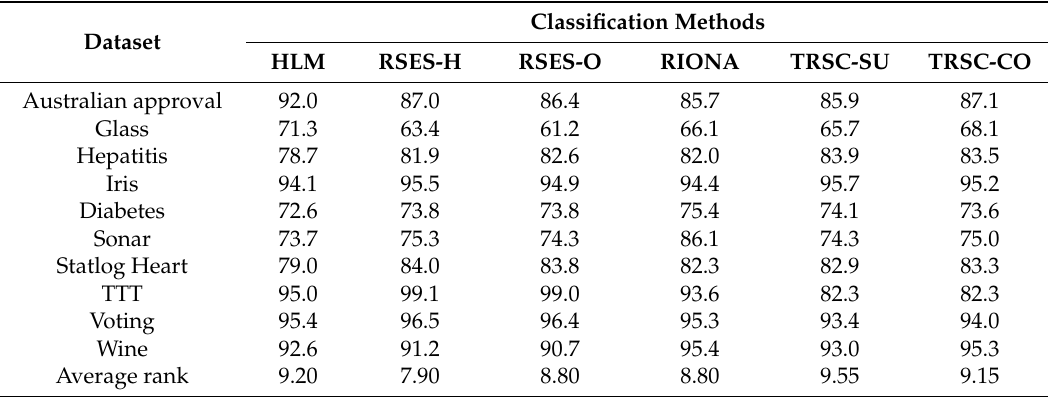
Table 3. Classification accuracy of different classification methods. HLM: A hierarchical version of the lattice machine; RSES-O: a rule-based method with shortening optimization; RSES-H: A hierarchical form of RSES-O; RIONA: Rule Induction with Optimal Neighborhood Algorithm; TRSC: Tolerance-rough-set-based classifiers; SU: Subset approximations; CO: Concept